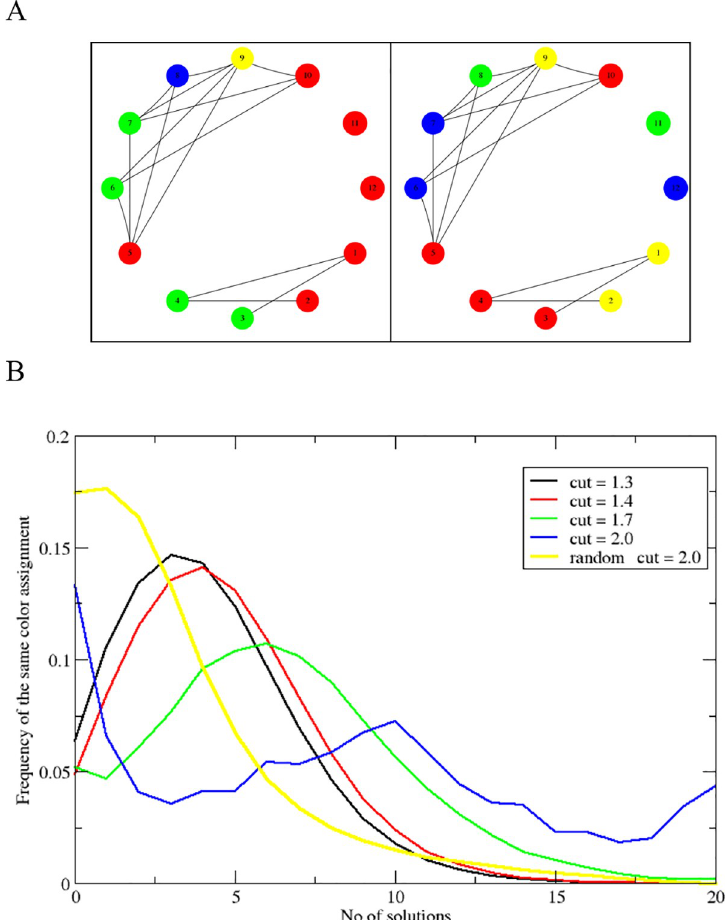
Fig 3. Alternative coloring solutions. A: Illustration of different colorings of the same conflict graph. B: Consistency between alternative coloring solutions in yeast HiC data. The figure shows the histograms of the number of similar color assignments among 20 possible coloring solutions. The histogram for the HiC contact conflict graph shows reasonable stability as evident by the fact that the histogram has its peak away from zero (a = 1.3,1.4, and 1.7). On the other hand, a random graph has its peak at zero which means that the coloring solution is less stable than real data. Finally, we see that the graph loses its coupling at high a, causing the peak at zero for a = 2.